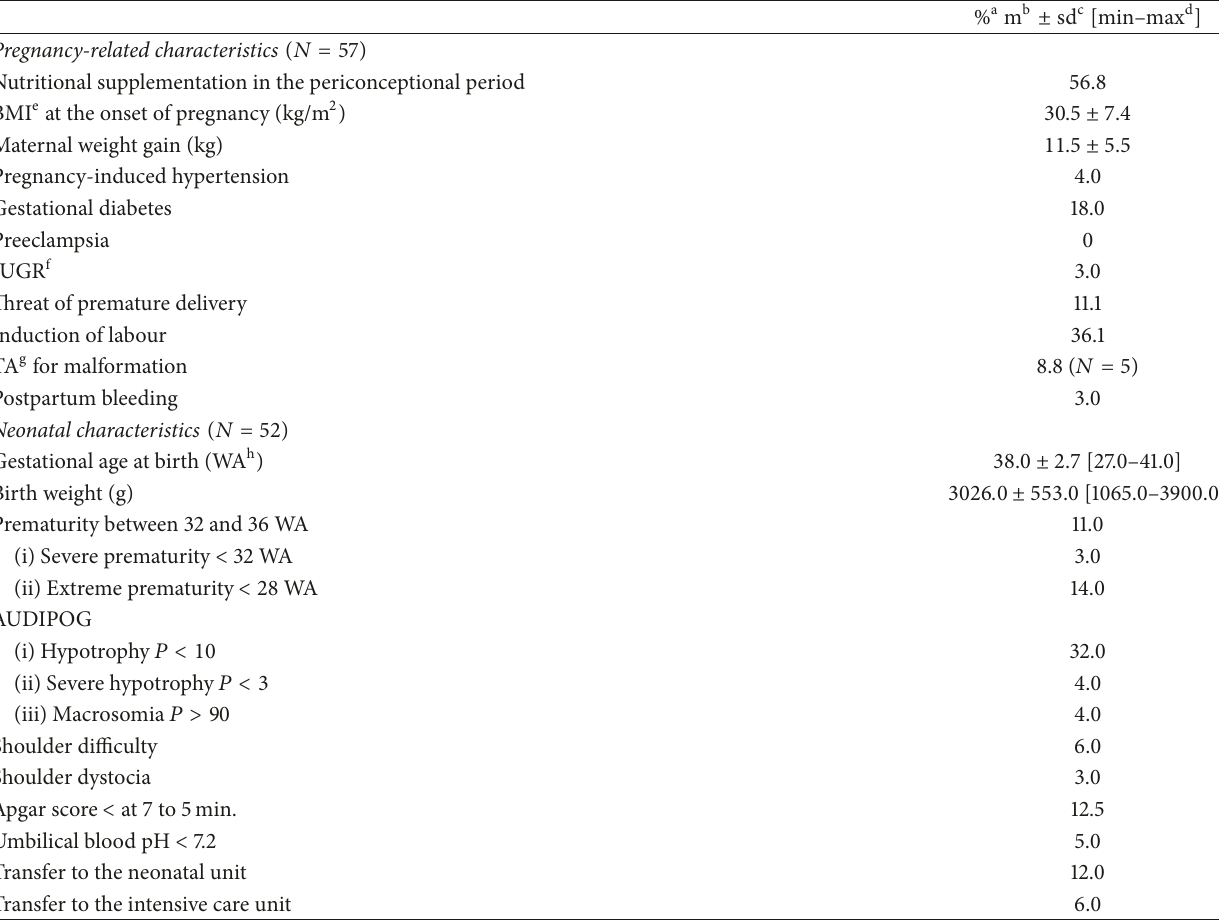
Table 3: Neonatal and pregnancy-related characteristics of 57 pregnancies in 48